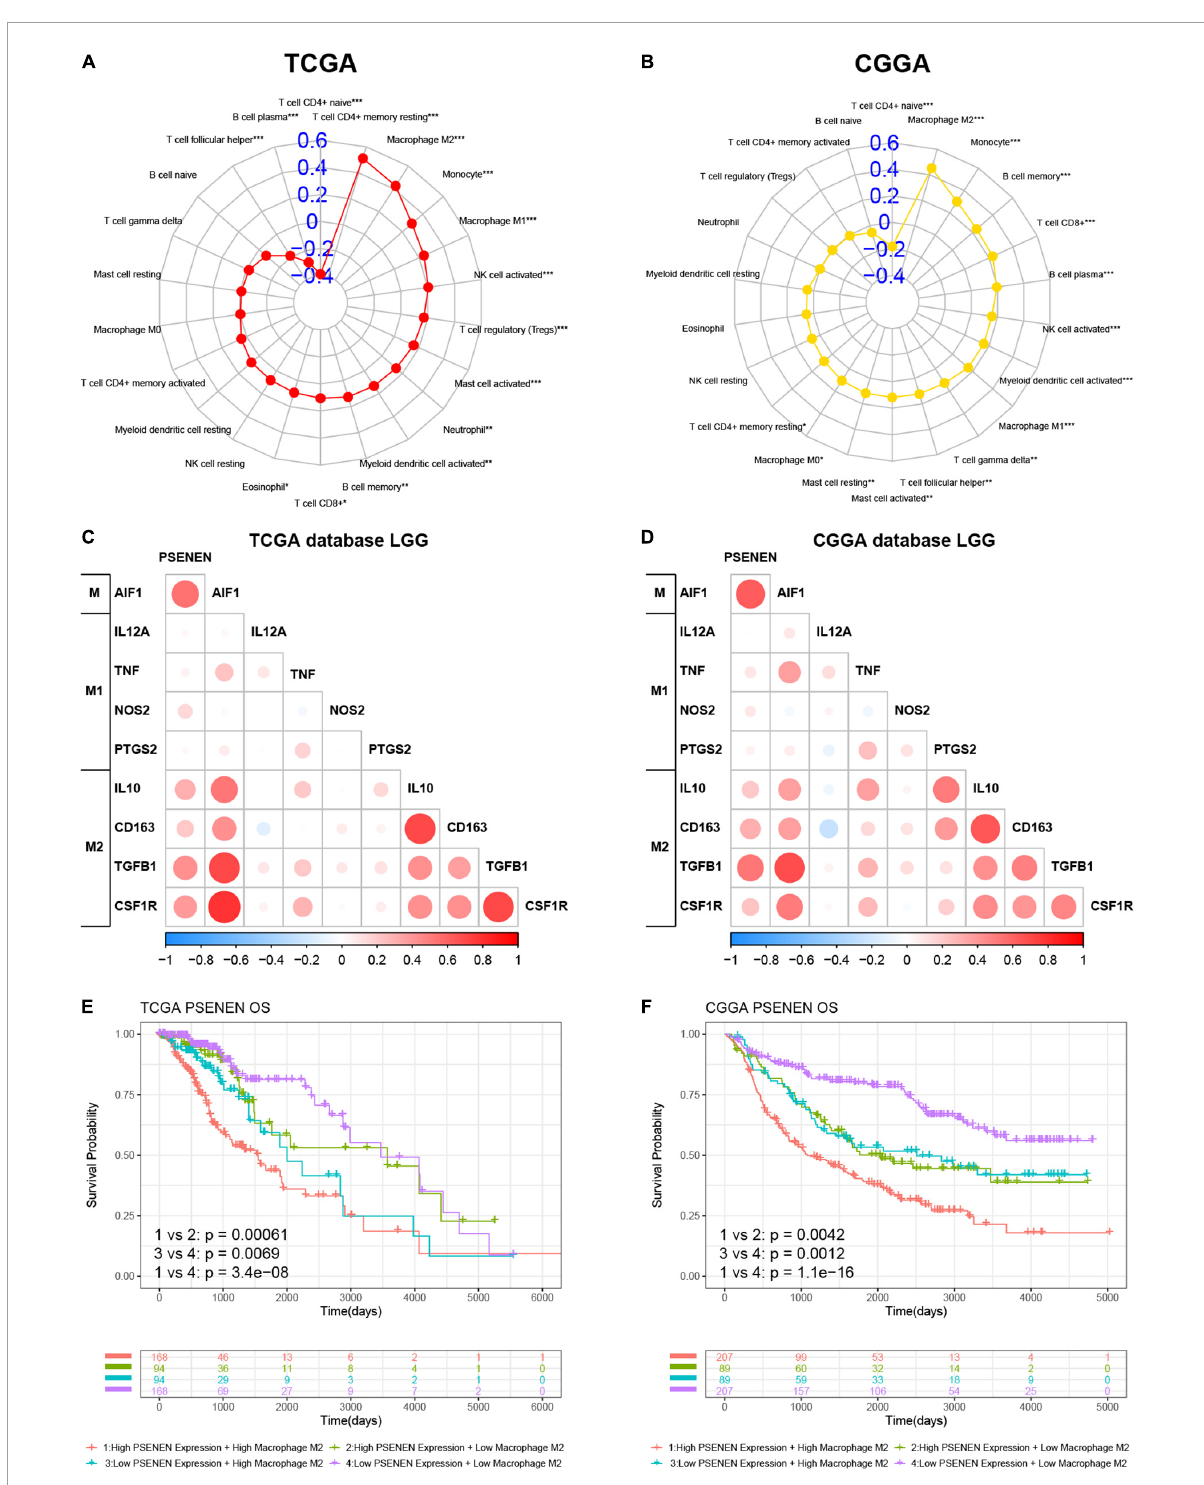
FIGURE6 Association analysis of PSENEN expression level with levels of M2 macrophages in LGG from the TCGA and CGGA databases. (A,B) The correlation between PSENEN and 22 types of infiltrating immune cells. (C,D) Nine classical phenotype markers of M, M1, and M2 macrophages were analyzed. Color depth and circle square represent the degrees of correlation. (E,F) Combination survival analysis based on PSENEN expression and macrophages M2. ”*”, “**”, and “***” indicate p < 0.05, p < 0.01, and p < 0.001,